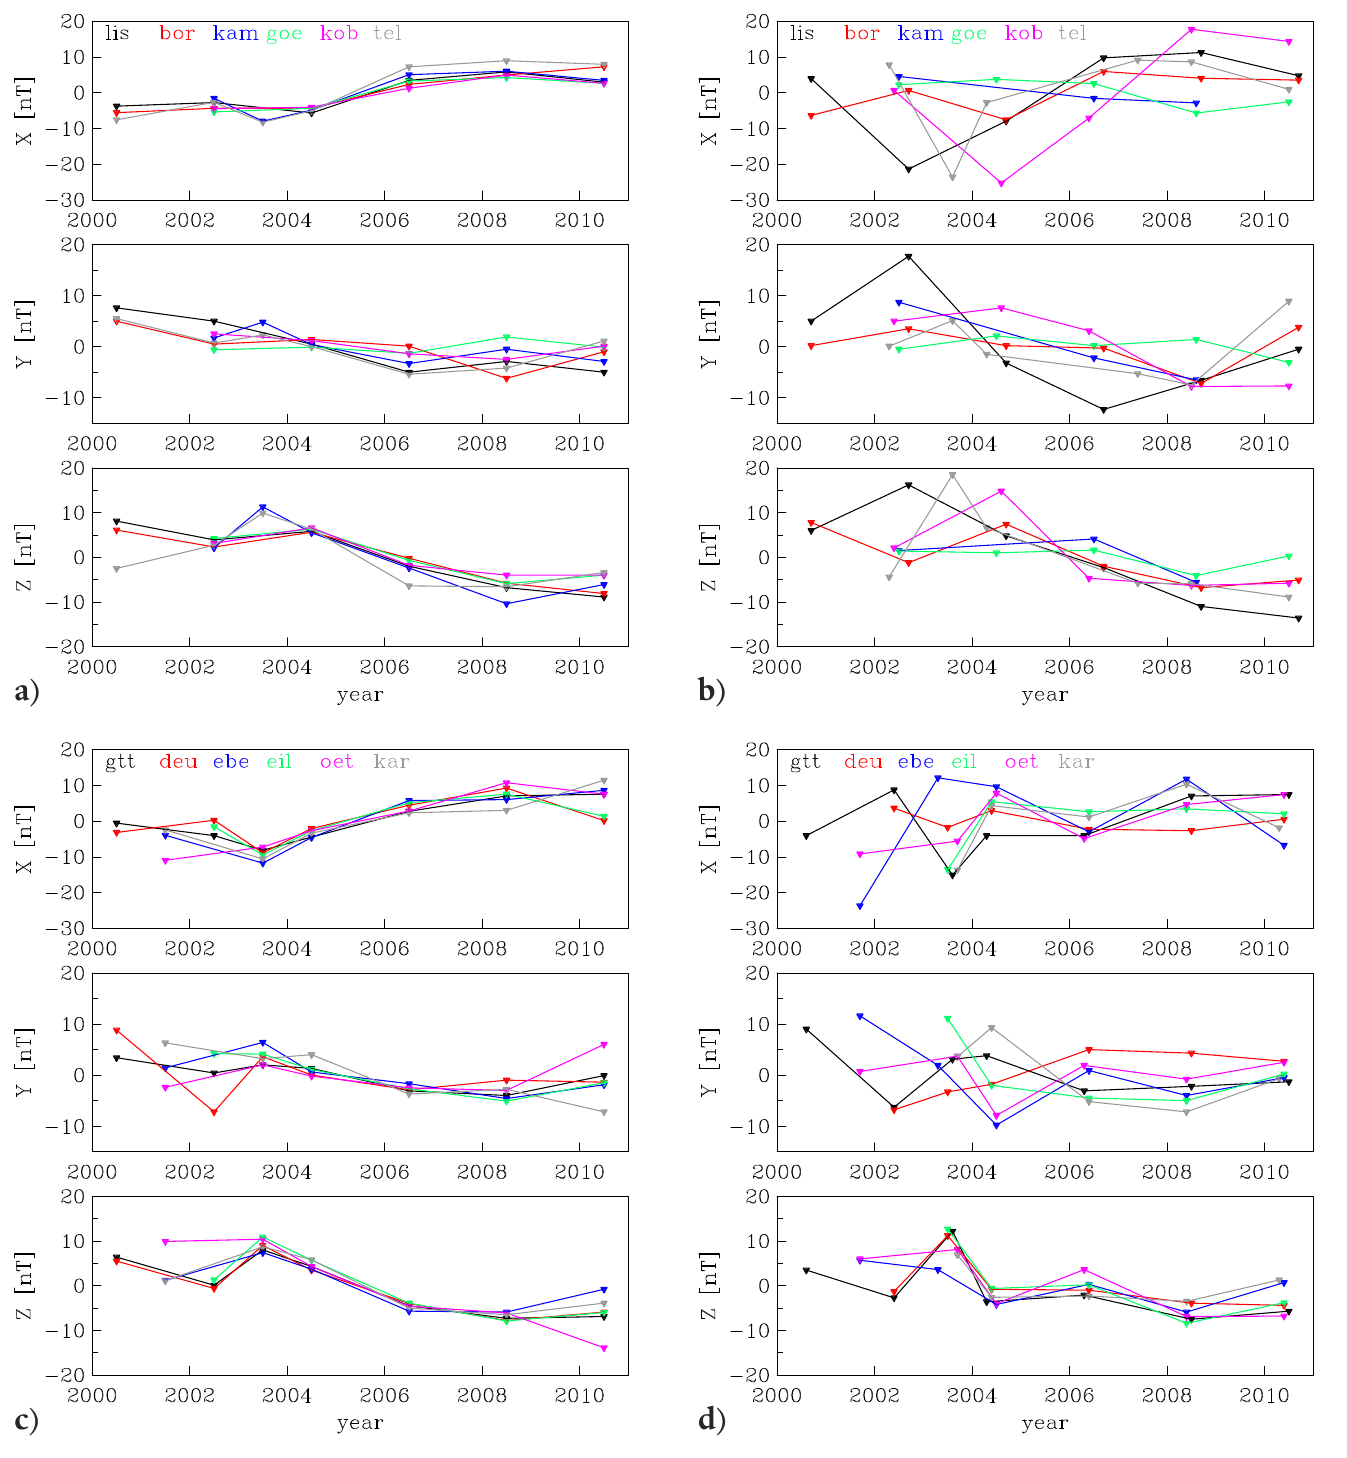
Figure 2. Repeat station data after subtraction of GRIMM3 core field predictions and constant average for North (X), East (Y) and vertical (Z) component. The left panels (a and c) show the annual mean results, the right panels (b and d) the quiet night time results. For better visibility the panels have been split up in northern (a and b) and southern (c and d)